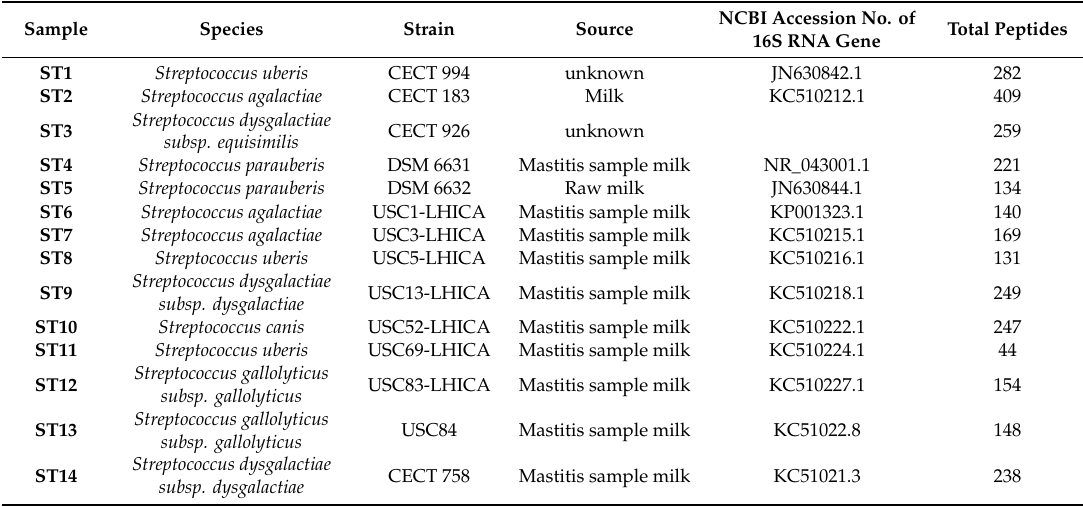
Table 2. Streptococcus spp. strains used in this study. Total peptides represents the number of peptides identified by LC–ESI–MS / MS and those analyzed by BLASTp. ATCC—American Type Culture Collection; CECT—Spanish Type Culture Collection; DSM—German Type Culture